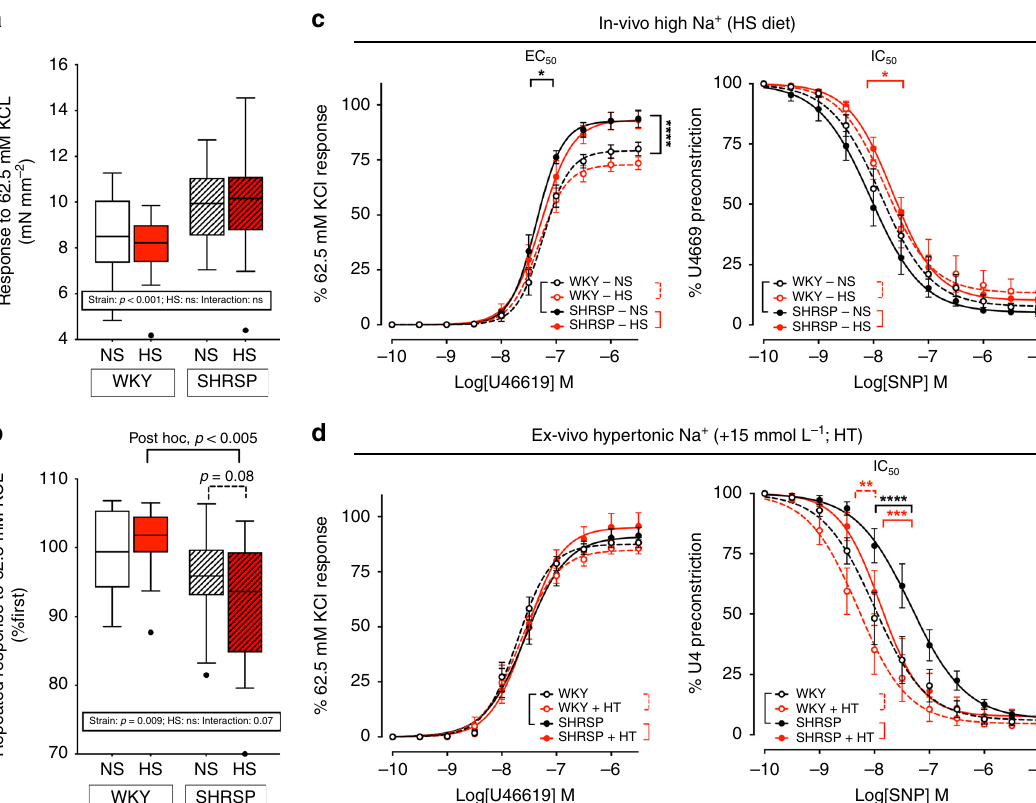
Fig. 3 Impact of in vivo and ex vivo Na + excess on vascular function of resistance arteries. Panels a , b contractile response to KCl, by strain and experimental treatment; box-and-whisker plots (Tukey: centre line, median; box limits, upper and lower quartiles; whiskers, 1.5x interquartile range; points, outliers); WKY -NS: n = 15 and HS n = 18, SHRSP -NS: n = 14 and HS n = 17; two-way ANOVA results at bottom and prede fi ned or post hoc (inter-strain) comparisons on top. Panel a the response to the fi rst KCl stimulation was higher in SHRSP than WKY but was unaffected by in vivo treatment; panel b the response to a second stimulation, expressed as percentage of fi rst peak response, was reduced in SHRSP , particularly upon HS. Panels c , d contraction and relaxation dose – response curves to U46619 (thromboxane A 2 receptor agonist; n = 11 – 17/group, please see Supplementary Table 1a, b) and SNP (endothelium-independent nitric oxide donor; n = 9 – 16/group, please see Supplementary Table 1a, b), respectively; mean ± SEM. Differences in maximal responses and half maximal effective/inhibitory concentrations (EC 50 and IC 50 , respectively) across groups are shown by brackets; * p < 0.05, ** p < 0.01, *** p < 0.001, **** p < 0.0001, at Extra sum-of-squares F test upon non-linear regression by least-square method. c Effect of 1% NaCl in drinking water (HS): HS did not worsen the hypercontractile phenotype observed in SHRSP rats (max response to U46619: SHRSP -NS vs. WKY -NS, p < 0.0001; SHRSP -NS vs. SHRSP -NS, p = 0.892; LogEC SHRSP -NS vs. WKY -NS, p = 0.017; SHRSP -NS vs. SHRSP -NS, p = 0.142), but reduced their sensitivity to NO- 50 to U46619: mediated relaxation (max response to SNP: SHRSP -NS vs. SHRSP -NS, p = 0.041; LogIC 50 to SNP: SHRSP -NS vs. SHRSP -NS, p < 0.0001); no signi fi cant effect was observed in WKY rats. d Effect of ex vivo 5 h incubation in a hypertonic ( + 15 mmol/l NaCl, HT) vs. physiological solution on vessels from NS rats: ex vivo hypertonic Na + excess did not affect contractile responses (max response to U46619: SHRSP -HT vs. SHRSP , p = 0.328; WKY -HT vs. WKY , p = 0.382; LogEC 50 to U46619: SHRSP -HT vs. SHRSP , p = 0.856; WKY -HT vs. WKY , p = 0.516), but induced oversensitivity to NO in both strains, opposite to in vivo HS (LogIC 50 to U46619: SHRSP vs. WKY , p < 0.0001, SHRSP -HT vs. SHRSP , p < 0.0001; WKY -HT vs. WKY , p = 0.007); none of these ex vivo effects would justify an increase in peripheral vascular resistance. Please see Supplementary Table 1a, b for all comparisons; source data are provided as a Source Data fi